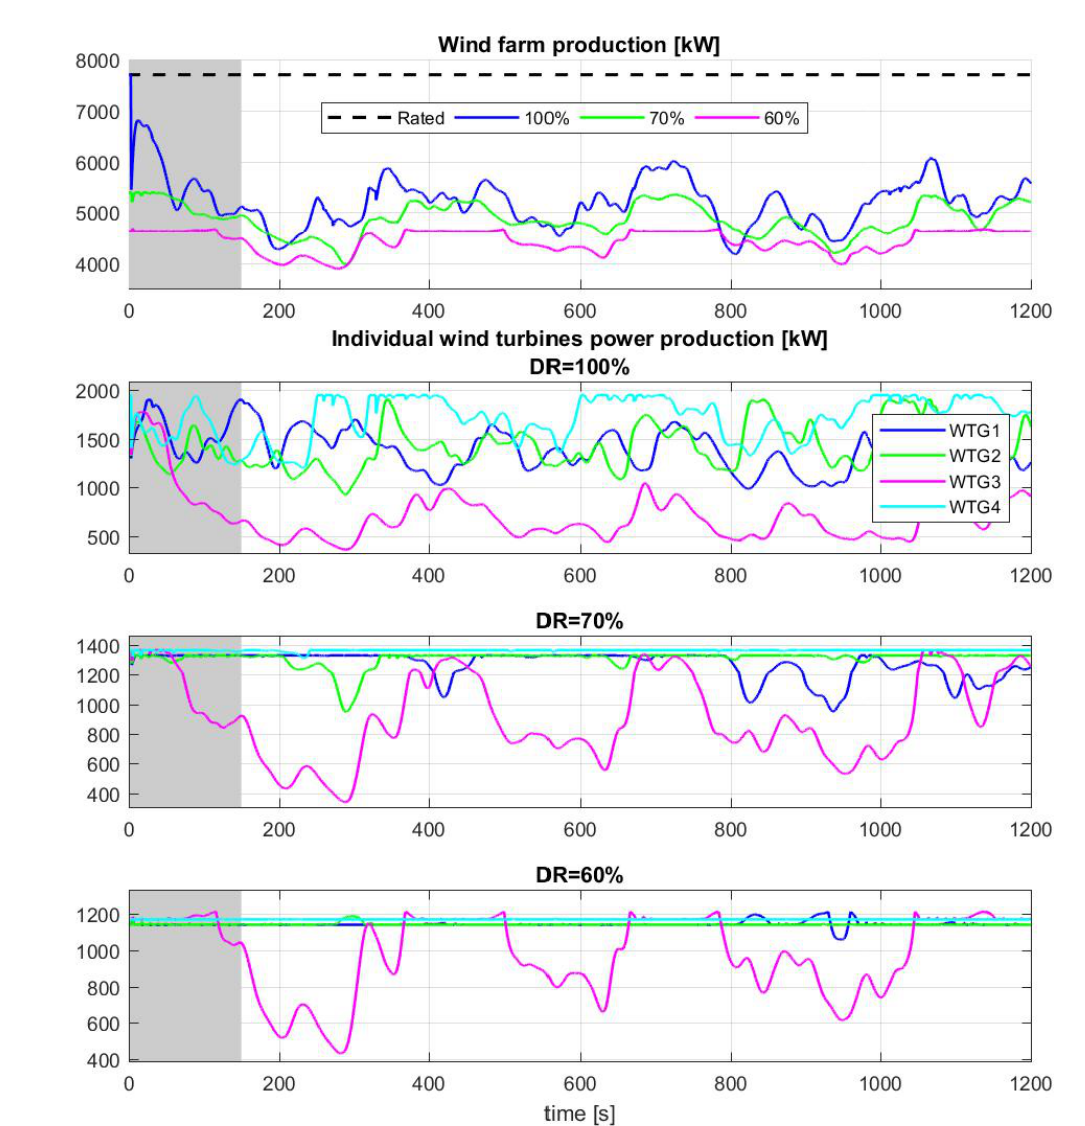
Figure 11. Power production of the wind farm (top) and of each individual wind turbine. Inflow condition of the simulation: Wind direction 147 ◦ (wake interaction between wind turbines) and wind speed below rated. Three constant de-rated signals applied on each wind